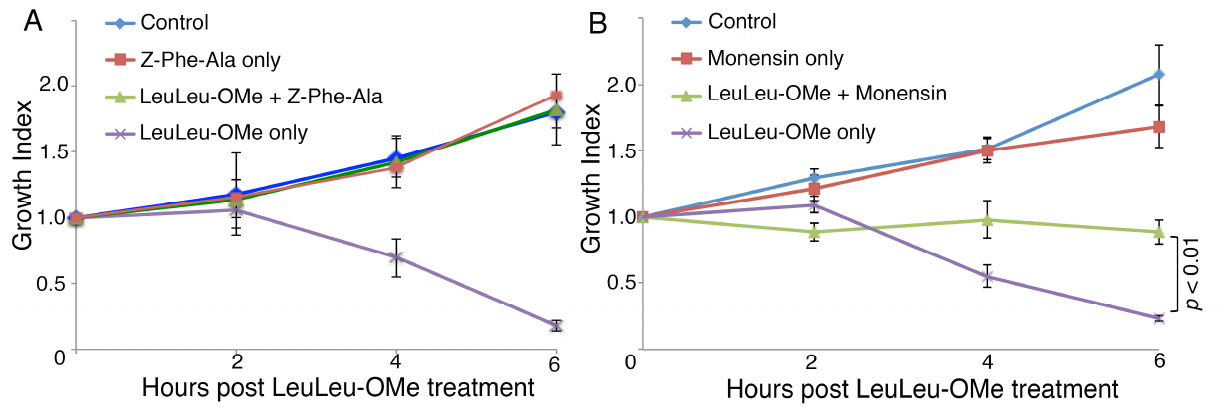
FIGURE 4: Treatment with a cathepsin inhibitor or monensin reduces LeuLeu-OMe-induced cell death. (A) Cells were treated with 10 µM Z- Phe-Ala or 30 µM LeuLeu-OMe, alone or in combination. (B) Cells pre-treated with 100 nM monensin for 30 min was then cultivated in the presence or absence of 30 µM LeuLeu-OMe. While monensin treatment alone had no observable effects on parasite growth (compared to control), monensin treatment significantly reduced LeuLeu-OMe-induced cytotoxicity. Results were presented as mean ± SD from 3 inde- pendent experiments. p value for the samples treated with LeuLeu-OMe only or LeuLeu-OMe + monensin at 6 h time point is indicated next to the